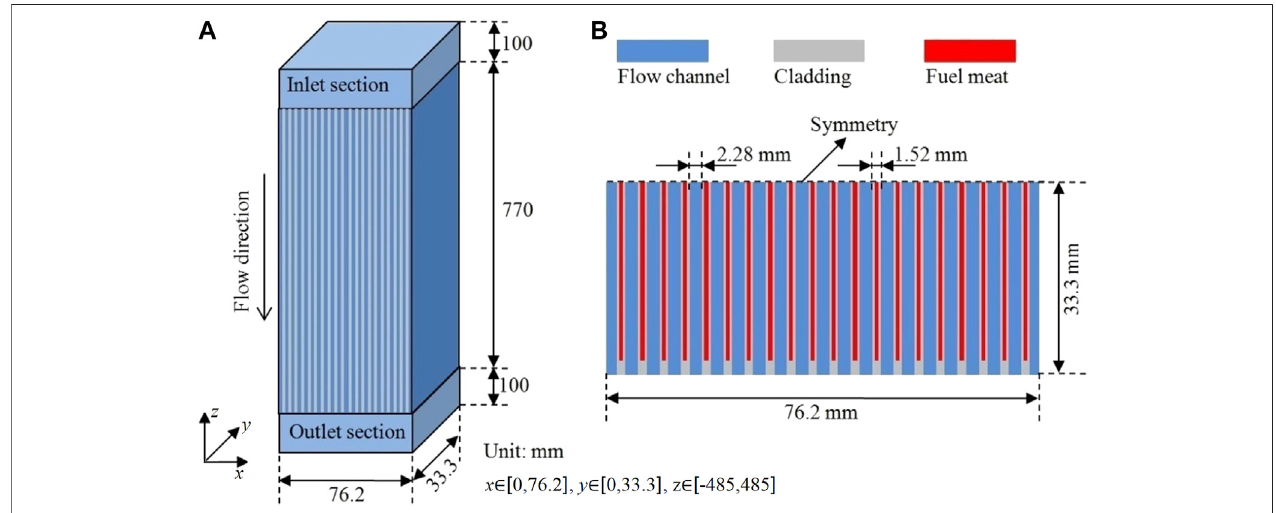
FIGURE 3 | Schematic of (A) simulation domain and (B) Cross section.